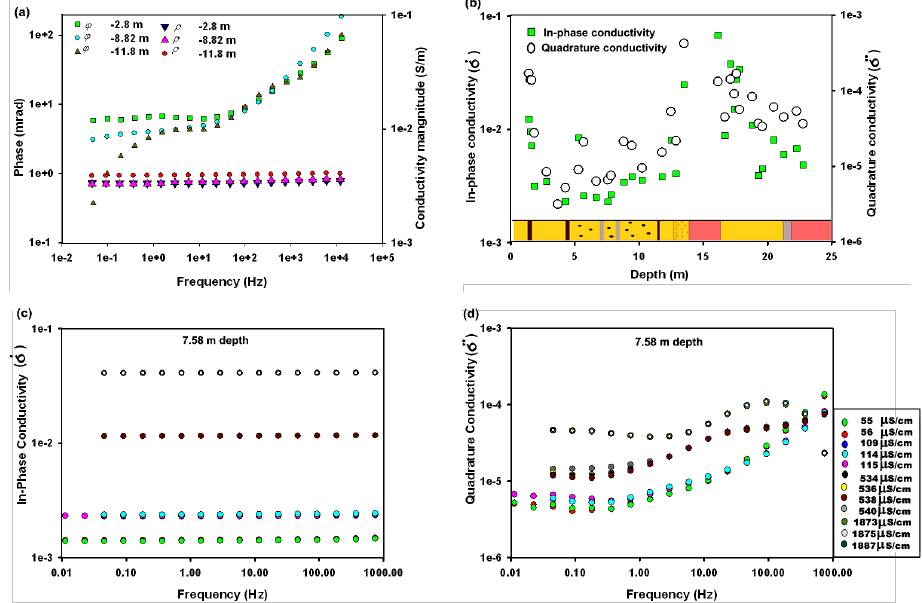
Fig. 6. (a) Exemplary SIP response at three samples at different depths (2.8 m, 8.82 m and 11.8 m) and (b) in-phase and quadrature conductivities (at 1.5 Hz) at different depths. (c and d) In-phase and quadrature conductivities at different water salinities of the collected sample at 7.58 m depth.